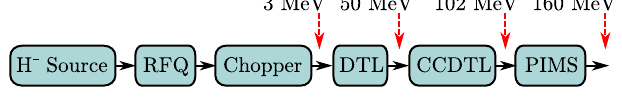
FIG. 4. LINAC4 block